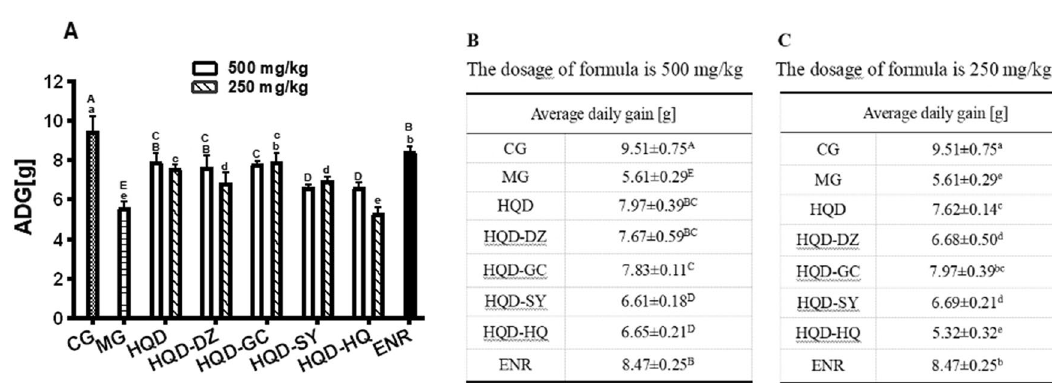
Figure 3. Average daily gain of chicks were represented in ( A – C ). The different letter superscript in the same column indicates that the difference is significant ( p < 0.05). CG, Control group; MG, Model group; DZ, jujube, Ziziphus jujuba ; HQ, Chinese skullcap, Scutellaria baicalensis ; GC, licorice, Glycyrrhiza glabra ; SY, white peony root, Paeoniae radix alba ; HQD, decoction consists of DZ, HQ, GC and SY; HQD-DZ, HQD absent of DZ; HQD-GC, HQD absent of GC; HQD-SY, HQD absent of SY; HQD-HQ, HQD absent of HQ; ENR, 10 mg/kg